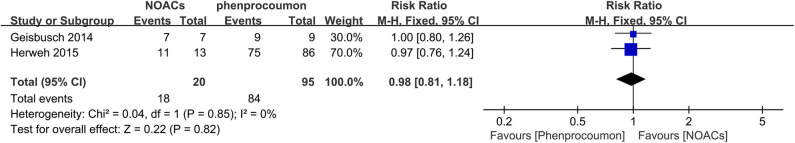
Recanalization between NOACs and phenprocoumon.